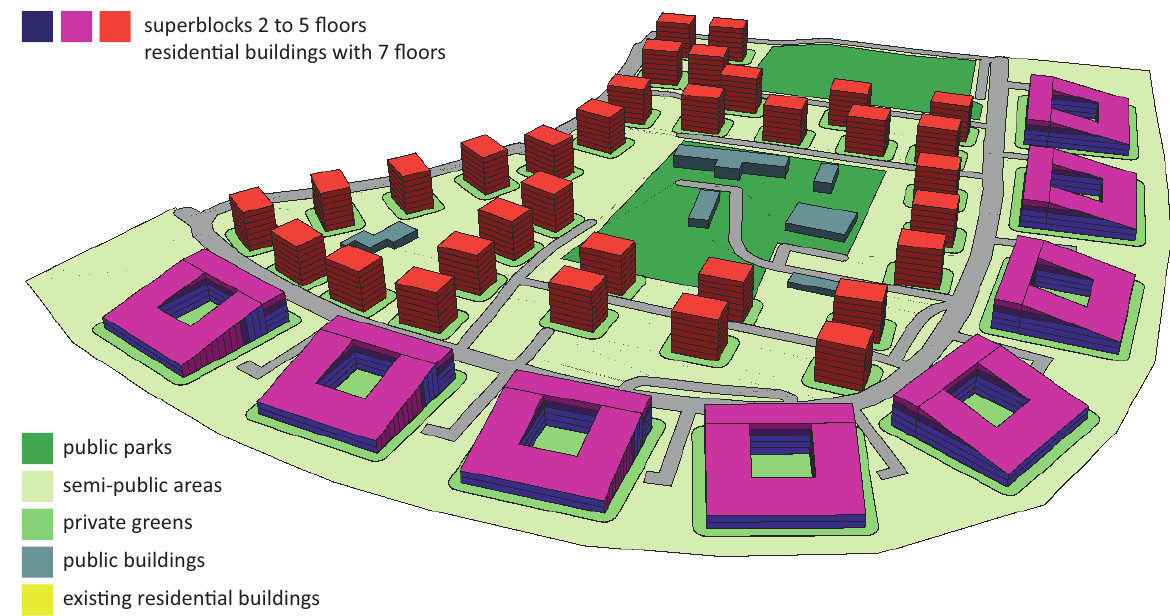
Figure 3. Alternative 1: “Economic alternative,” promoting the real‐estate level of the neighborhood. Urban Planning, 2021, Volume 6, Issue 4, Pages